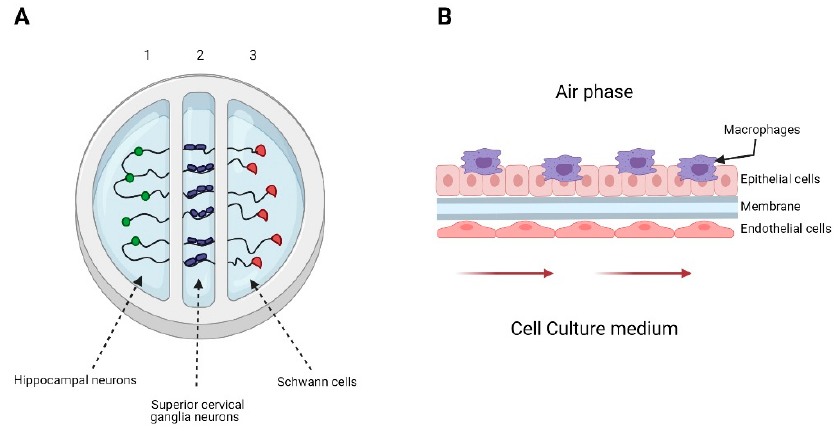
Figure 2. Examples of organs-on-a-chip used in viral infection studies. ( A ) Representation of the 3D-printed system developed by Johnson et al. The system consists of 3 chambers, seeded with hippocampal neurons in chamber 1, superior cervical ganglia neurons in chamber 2, and Schwann cells in chamber 3. They only infected chamber 2 with pseudorabies virus. ( B ) Representation of the alveolus model generated by Deinhardt-Emmer et al. The system consisted of a chamber divided by a porous membrane. The upper phase was seeded with a co-culture of alveolar epithelial cell and monocyte-derived macrophages and exposed to an air phase. The lower side contained endothelial cells, and the culture medium was perfused using a peristaltic pump.